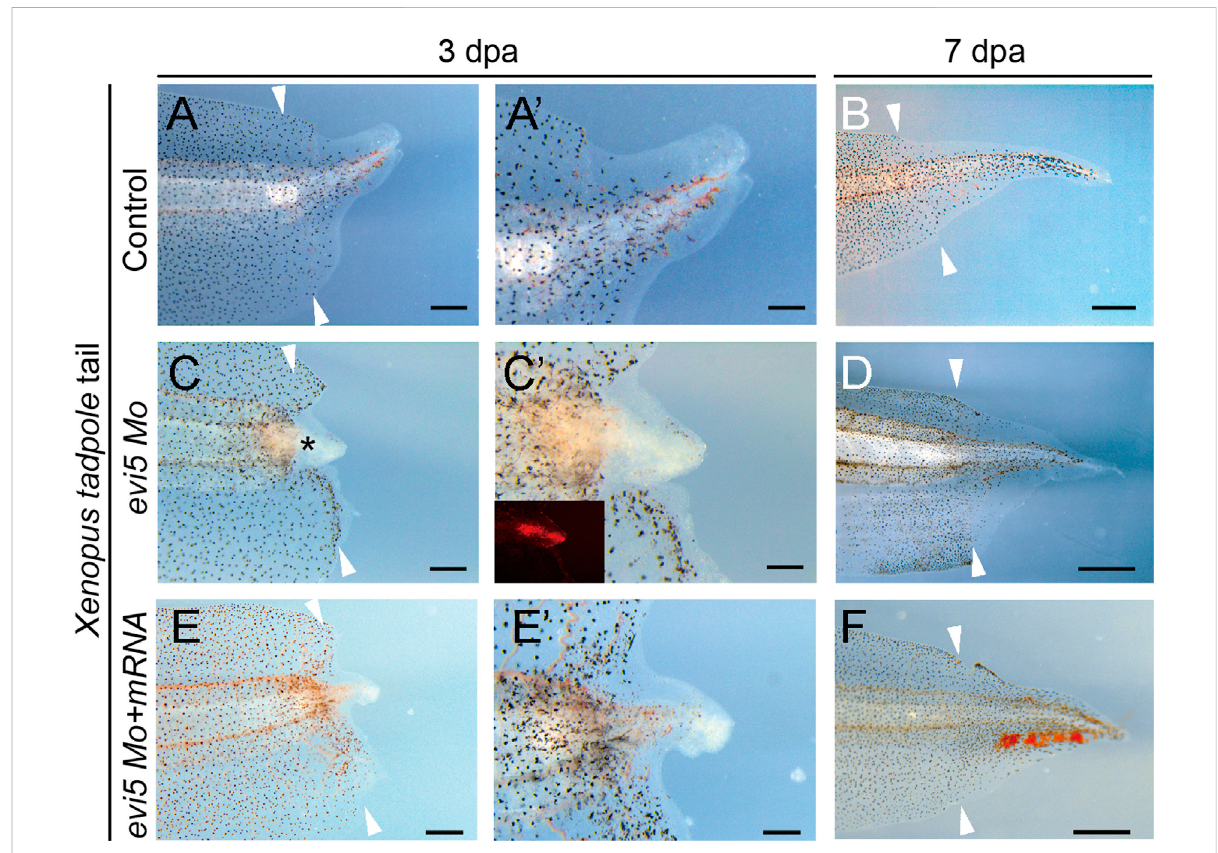
FIGURE 5 Tail regeneration in Xenopus tadpoles after evi5 Mo injection. (A – B) Regenerating tadpole tail at 3 and 7 dpa in a control tadpole. (C – D) RegenerationoftheMo-injected tailwasdelayedcomparedtocontrols. *marksthetailblastemaregionlackingpigmentcells. (E – F) Co-injectionof evi5 Mo and evi5 mRNA partially rescued the inhibitory effect of evi5 Mo on tail regeneration. (A ’ , C ’ , E ’ ) High magni fi cation images of tadpole tails at 3 dpa. Fluorescence signal in inset (C ’ ) indicates the delivery of Mo. Scale bars represent 500 μ m in (A,C,E) , 200 μ m in (A ’ , C ’ , E ’ ) , and 1 mm in (B,D,F)